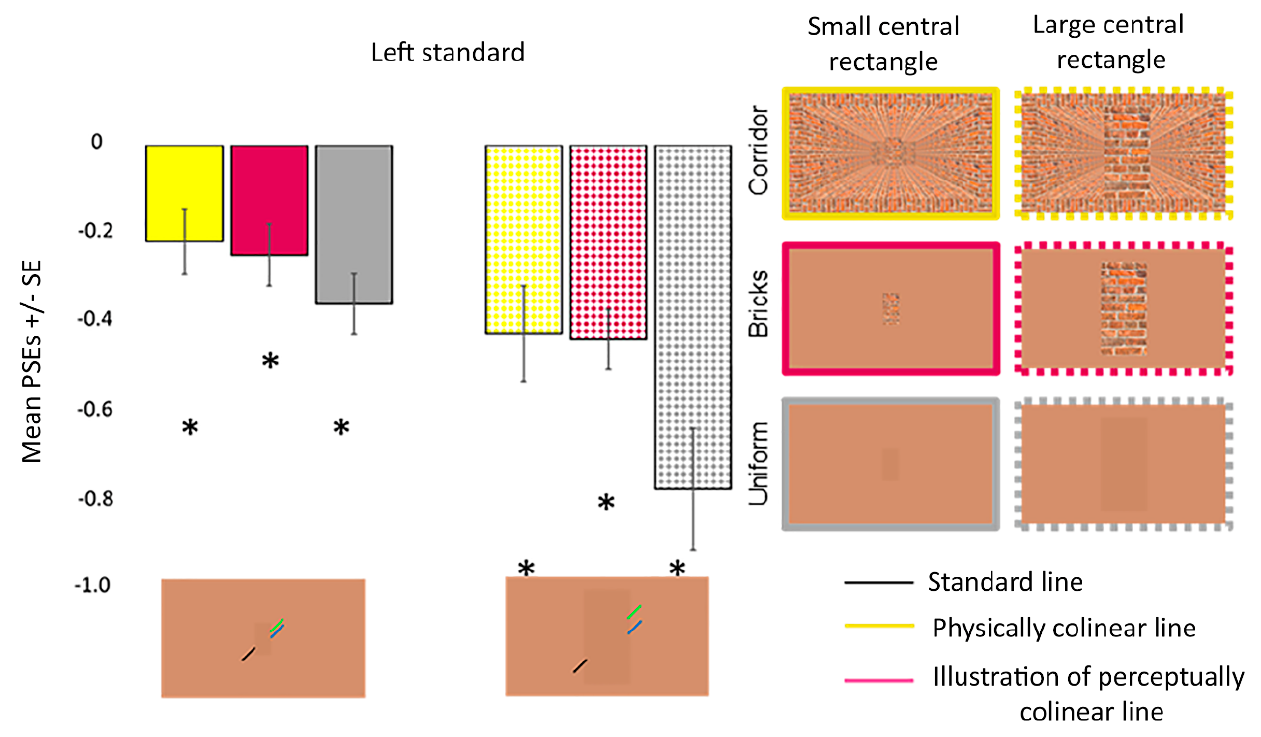
Figure 9. PSEs for the different conditions in experiment 3. Asterisks (*) denote differences from the physical width at p < 0.050 after correcting for multiple comparisons using the Bonferroni method. PSEs were computed from psychometric functions. Error bars denote standard errors for within-subject contrasts as described by O’Brien and Cousineau